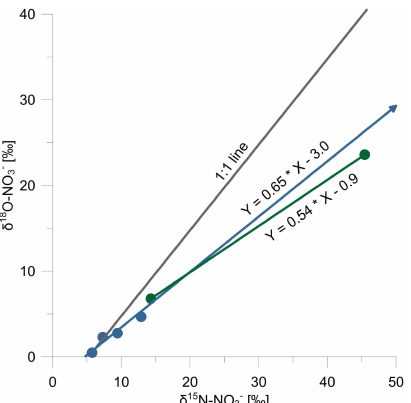
Figure 5. δ 18 O vs. δ 15 N plot of nitrate with the typical trajectory of 1 for denitrification obtained under laboratory conditions (black line), calculated trajectory of 0.65 for the n-damo zone (20m and above, blue line) and around 0.5 for the anammox zone (20–22m, green